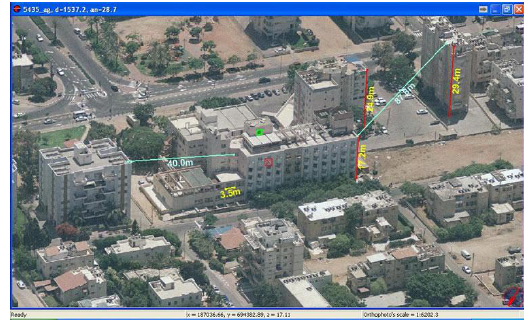
Figure 5. Height and distance measurements (Aeromap, 2006)